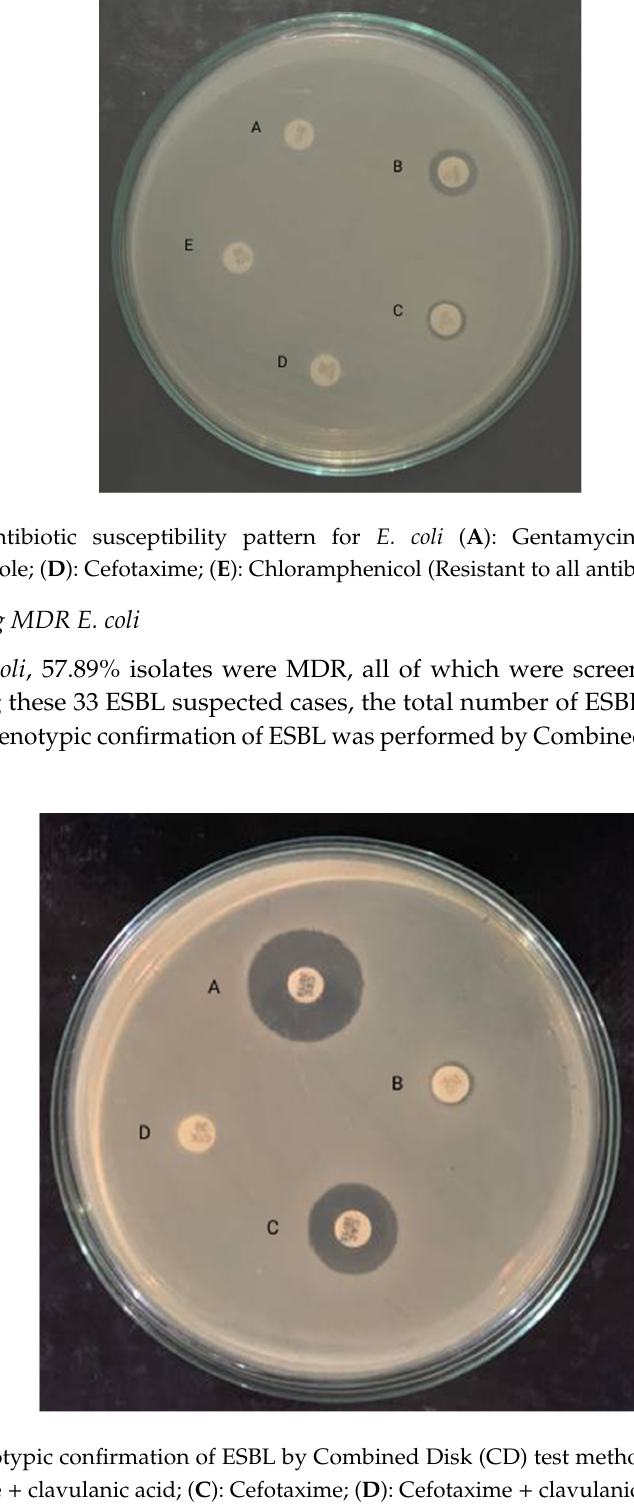
Figure 3. Phenotypic confirmation of ESBL by Combined Disk (CD) test method. ( A ): Ceftazidime; ( B ): Ceftazidime + clavulanic acid; ( C ): Cefotaxime; ( D ): Cefotaxime + clavulanic